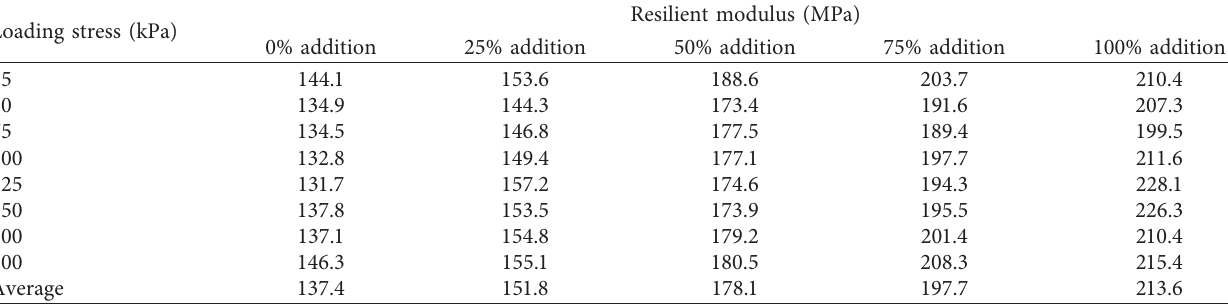
Table 6: Resilient modulus results of gradation